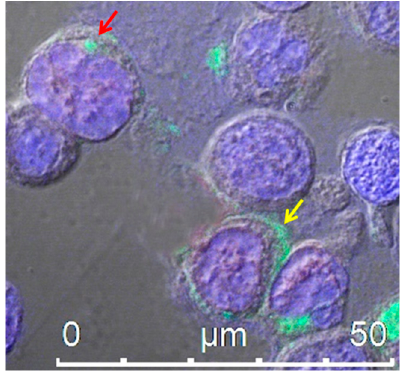
Figure 2. Confocal microscope analysis of HEK293T cells transfected with an expression vector encoding Nef mut fused to an scFv, labeled with an anti-Nef monoclonal antibody and Alexa 488-conjugated anti-mouse IgG antibody. The picture shows intracellular localization of the fusion protein product in intracytoplasmic vesicle aggregates (red arrow) and at the plasma membrane (yellow arrow). DAPI (blue fluorescence) was used to highlight cell nuclei. Scale bar is shown.